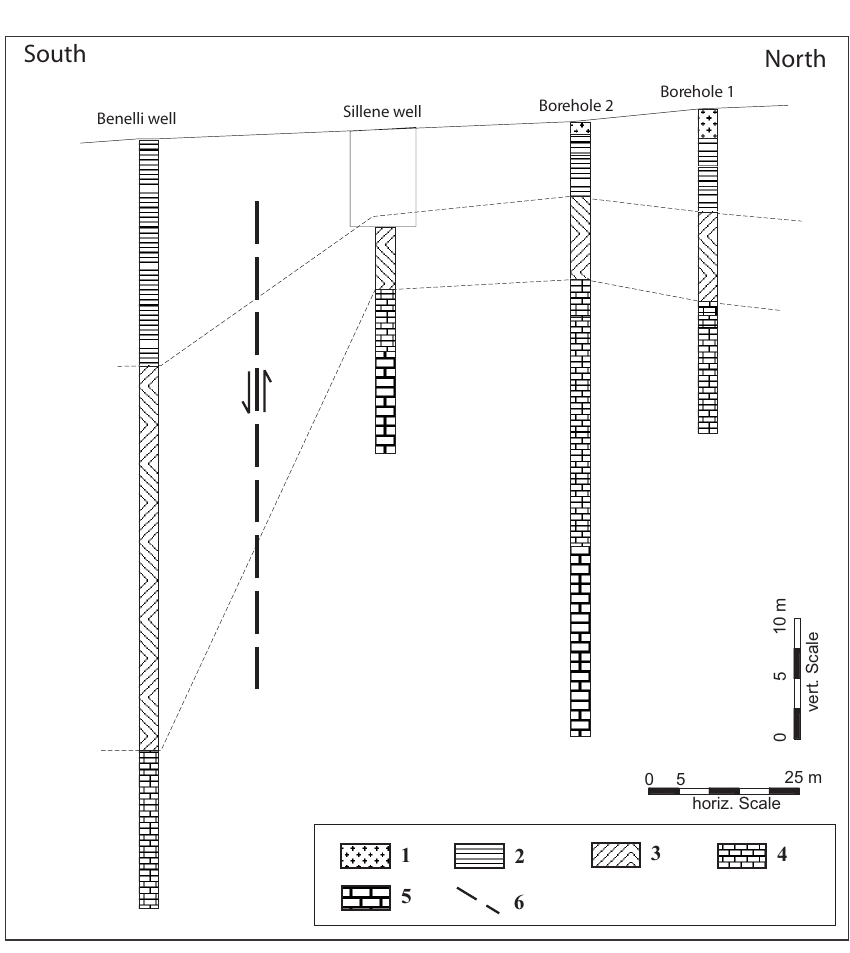
Fig. 4. Geological section: 1 = fill; 2 = sands and clayey sands; 3 = clayey turbidites; 4 = dolomitic sands; 5 = «calcare cavernoso» breccias; 6 =